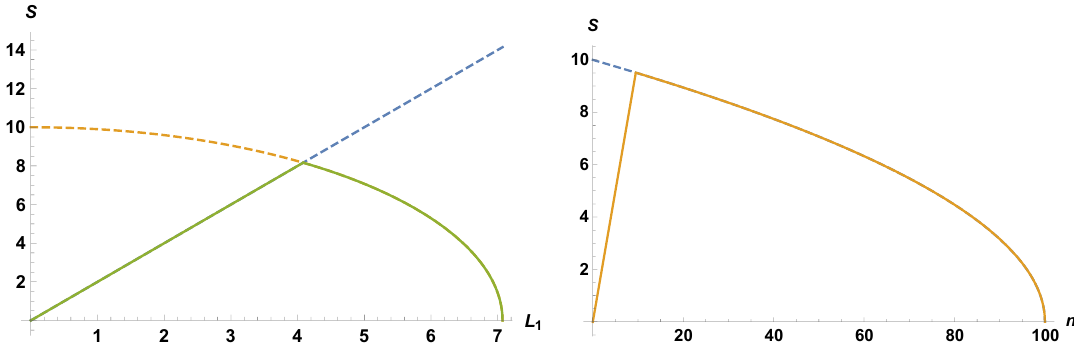
Figure 7. Page curves corresponding to the left: three and right: n boundary